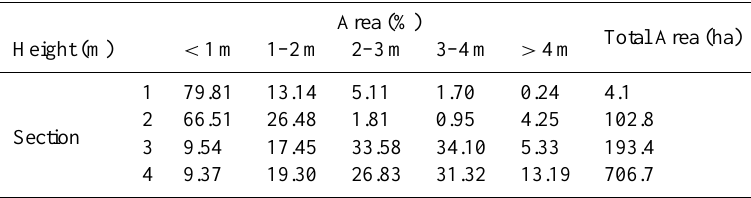
Table 6. Water height for the flood-prone areas in the modelled